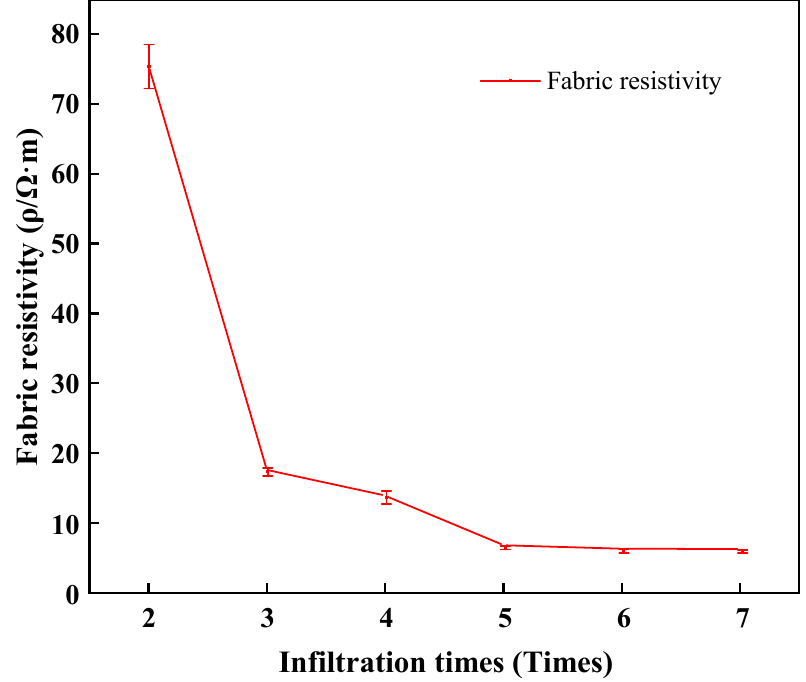
Figure 4. Fabric resistivity with different impregnation times.